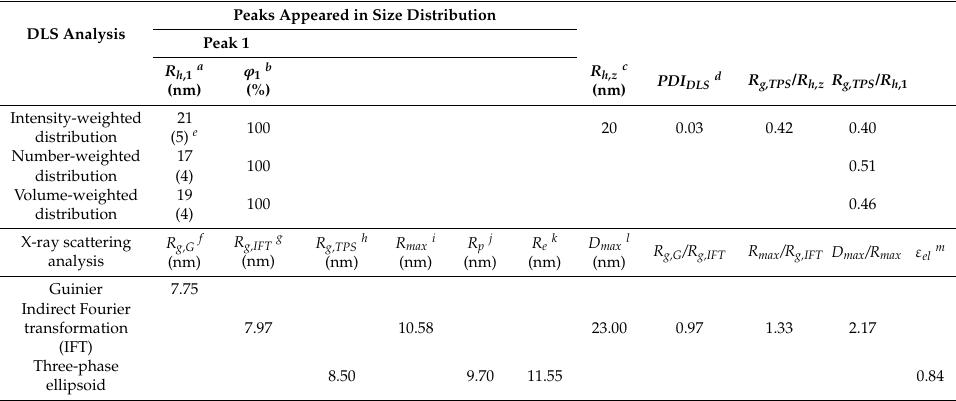
Table 2. Structural parameters of the normal c -PDGE- b -PTEGGE micelle formed in a mixture of 75 wt % ethanol and 25 wt % water, which were analyzed by DLS and X-ray scattering